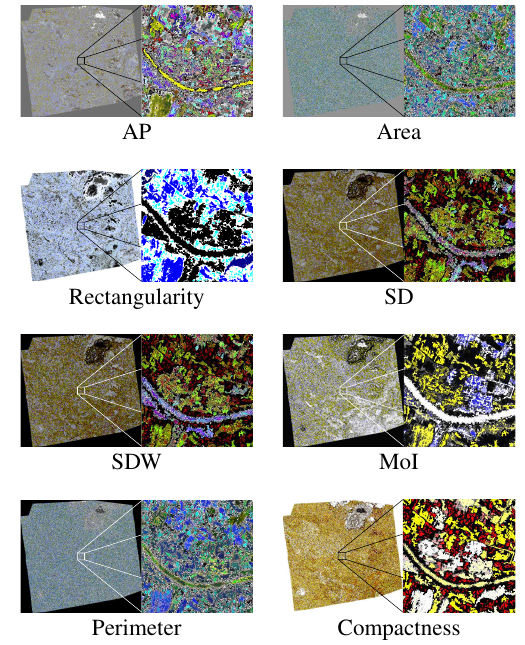
Figure 6. Featues profile with the Podgorica data Figure 8 using fake color (thresholds 10 , 100 , 5000 as